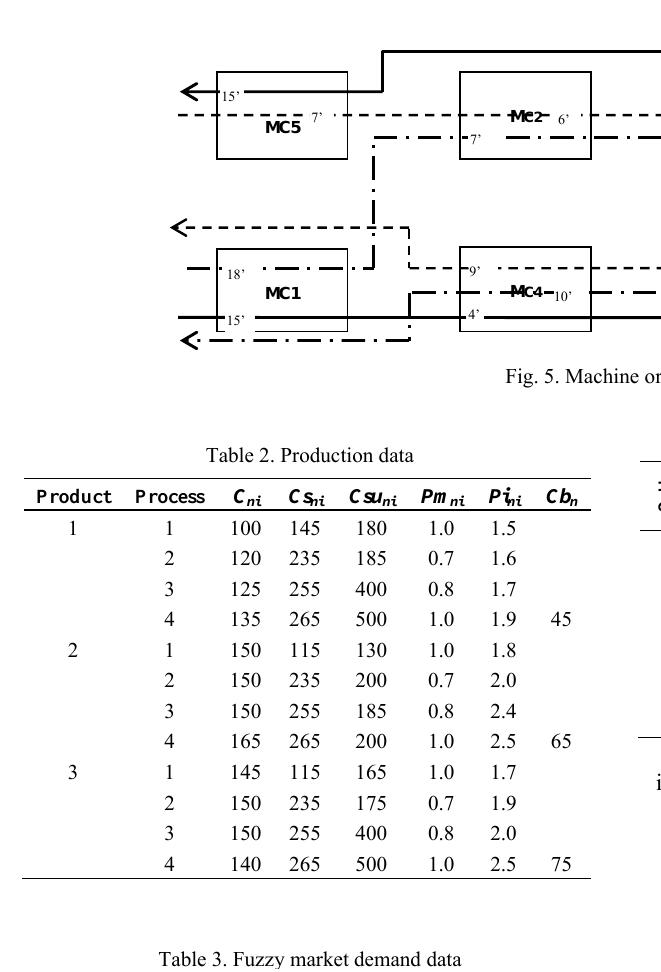
Table 3. Fuzzy market demand data